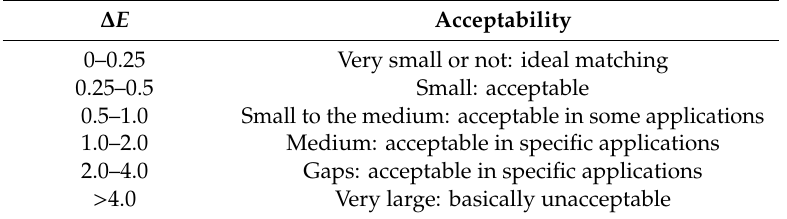
Table 5. E ff ect of color di ff erence on the acceptability of waterborne